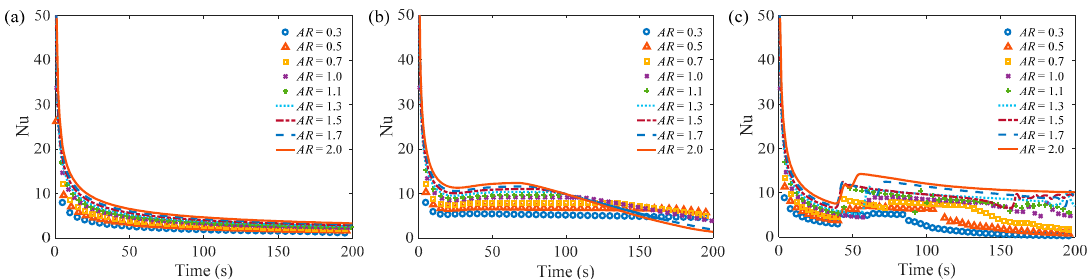
Figure 11. Nusselt numbers of the PCM in rectangular enclosures with di ff erent aspect ratios by heating the di ff erent sides. ( a ) Heating the top side; ( b ) heating the right side; ( c ) heating the bottom side.